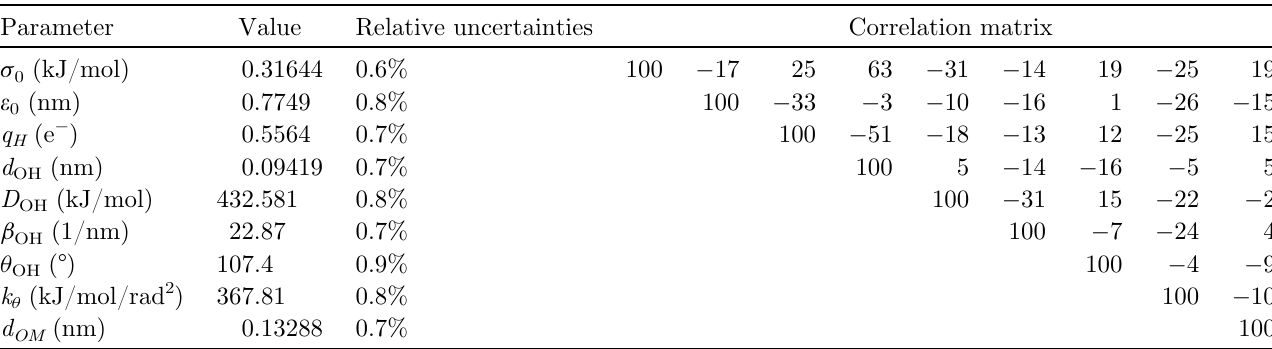
Table 4. Relative uncertainties and correlation matrix between the CAB model parameters after the fi tting procedure. Parameter Value Relative uncertainties Correlation matrix